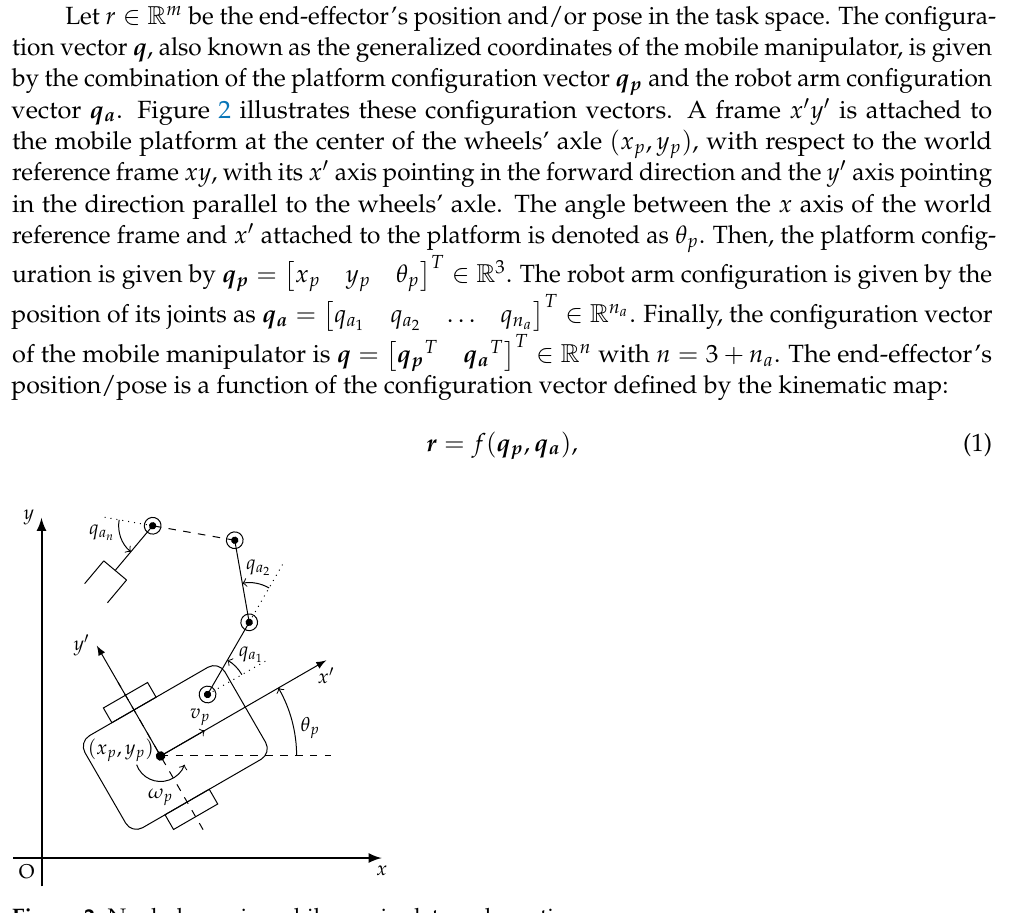
Figure 2. Nonholonomic mobile manipulator